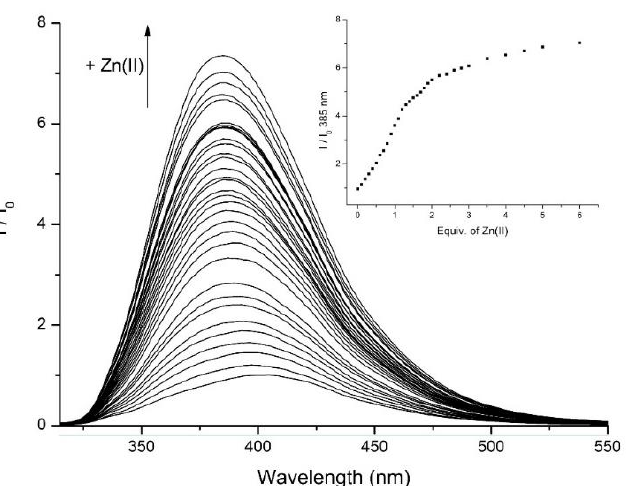
Figure 8. Variation of the fluorescence emission spectra of L by adding Zn(ClO 4 ) 2 registered in an ACN–aqueous HEPES pH 7.4, 4:1 v/v solvent mixture. Inset: trend of emission intensity of L at 385 nm. [ L ] = 3.2 × 10 − 6 mol dm − 3 . λ ex = 305 nm. Emission intensities are relative to the free